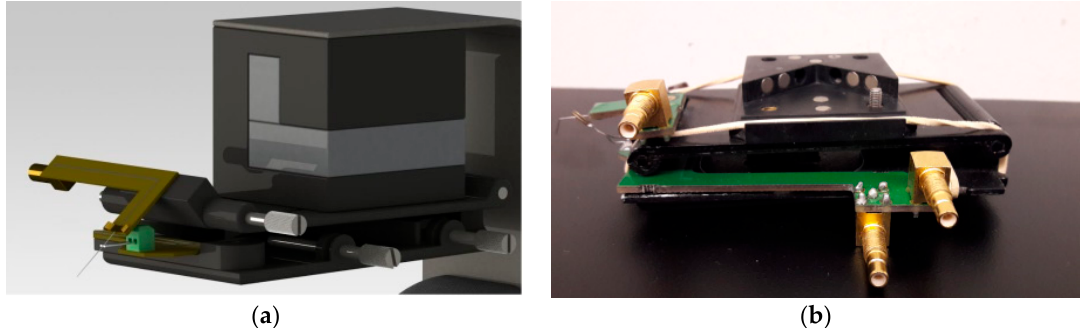
Figure 2. ( a ) 3D CAD design of the head. ( b ) Photograph of the designed head for the multitip system. The wire and the QTF can be positioned independently and precisely by using micrometric screws. Rubber strips are used to maintain the mechanical contact between the wire and the QTF without the need of any glue.